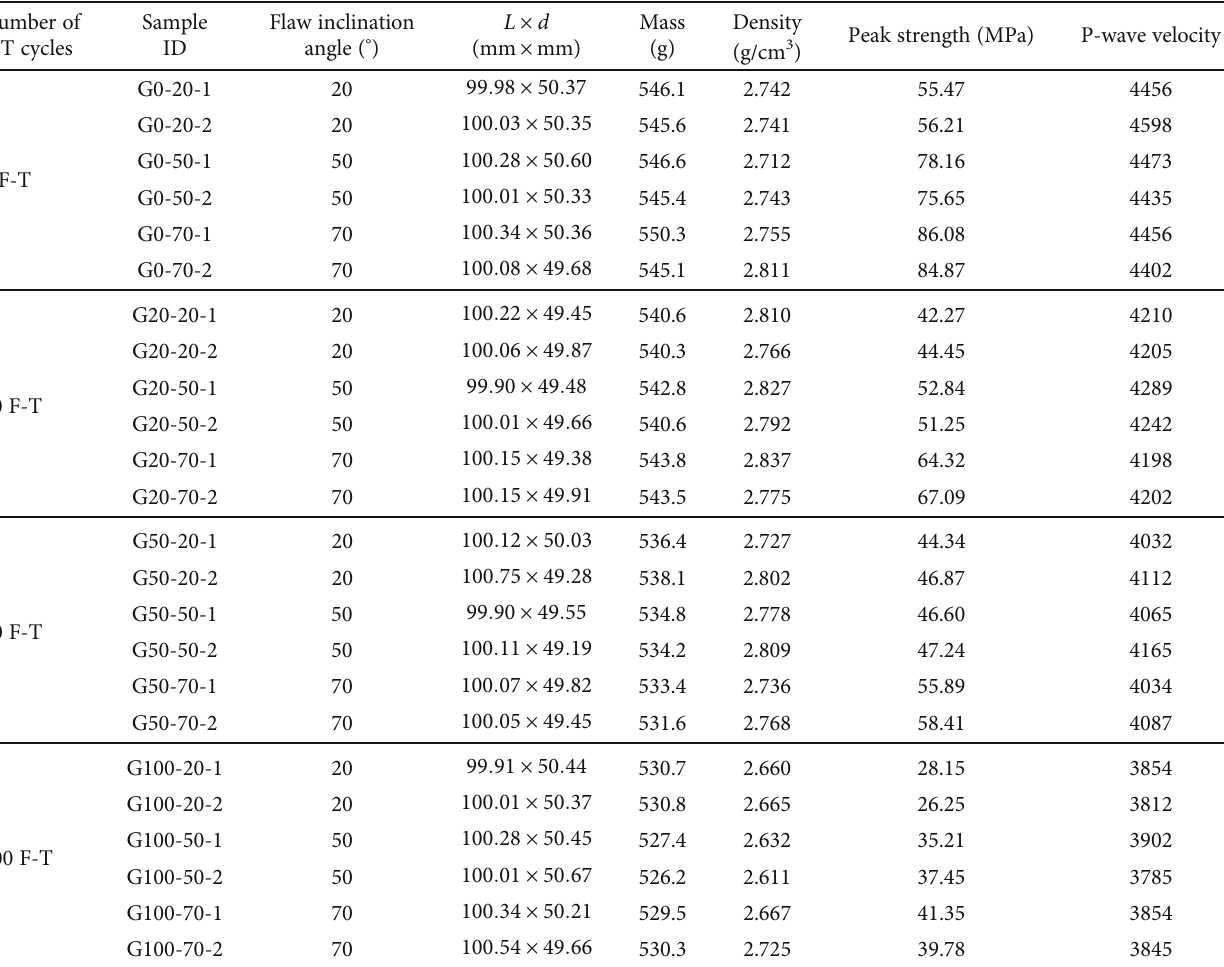
Figure 5: Preparation of the granite samples containing two fl aws. (a) Scheme of the preparation project. (b) A water-jet system used to produce the fl aws with its aperture of 1 mm. (c) Samples used to conduct the experiments. Table 1: Summarization of the basic physical and mechanical parameters of granite after F-T